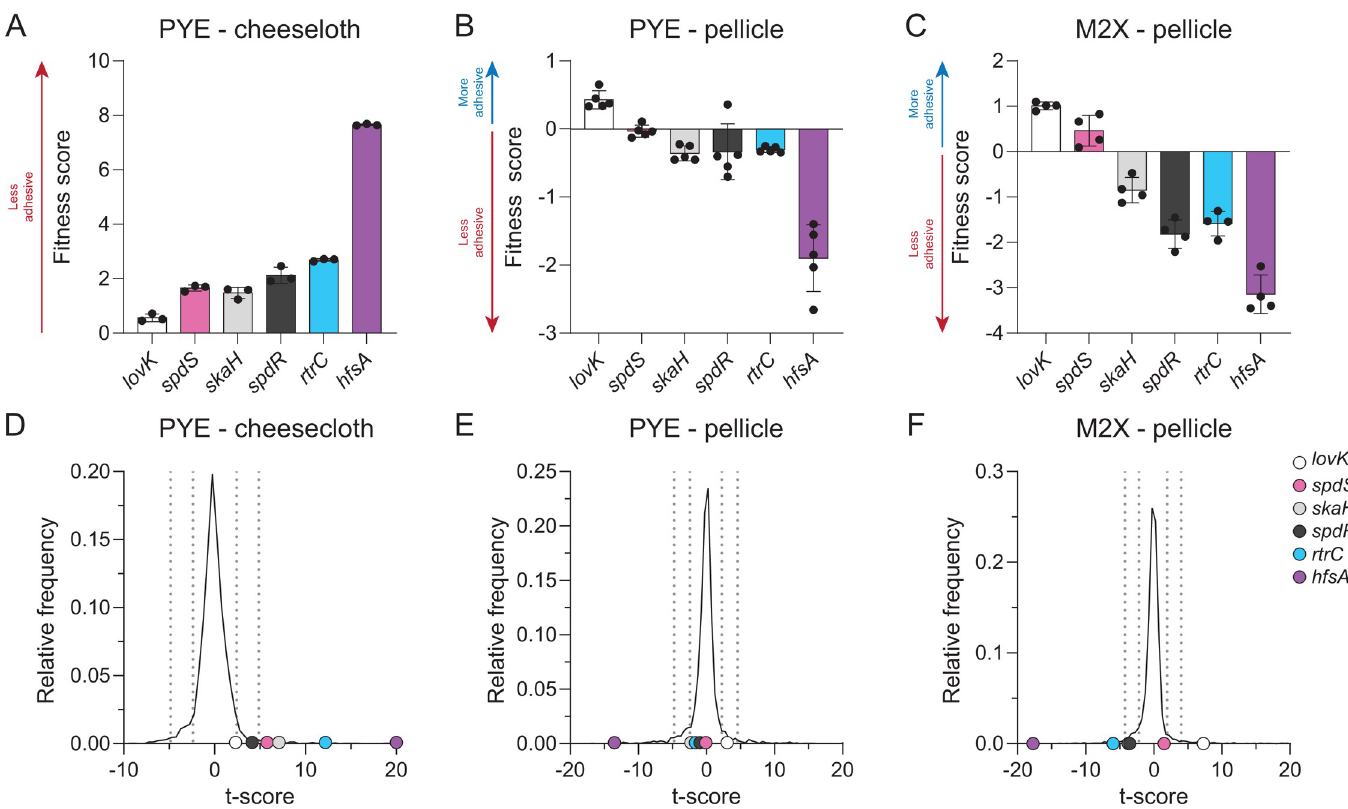
Fig 7. Mutant fitness profiles in cheesecloth adherence and pellicle assays. A-C) Composite fitness scores of C . crescentus strains harboring transposon insertions in adhesion regulatory genes ( lovK , spdS , skaH , spdR , and rtrC ) and a representative holdfast synthesis gene ( hfsA ) after (A) 5 days of serial passaging in the presence of cheesecloth where strains were sampled from the supernatant, which is enriched with non-adherent cells [22], ( B) 4 days of static cultivation in complex (PYE) medium where strains were sampled from the pellicle at the air-liquid interface, or ( C) 7 days of static cultivation in M2-xylose defined medium where strains were sampled from the pellicle at the air-liquid interface. Data in panels A-C show the mean ± standard deviation, with experimental replicates plotted as points (n = 3 to 5 depending on the experiment). D-F) Frequency distribution of mean t-value for each gene in the full dataset after (D) passaging in the presence of cheesecloth, (E) static growth in complex (PYE) medium, or (F) static growth in M2-xylose defined medium. The t-value is the fitness value of a gene divided by a variance metric based on the total number of reads for each gene (as previously described [61]) and provides a metric to assess the significance of mutant fitness values. Labeled dots mark the t-values of adhesion regulator mutants ( lovK , spdS , skaH , spdR , and rtrC ) and a representative holdfast synthesis gene ( hfsA ). Dotted vertical lines mark boundaries that contain 68%, and 95% of the t-values in each experiment, which would reflect one and two standard deviations in a normally distributed set.